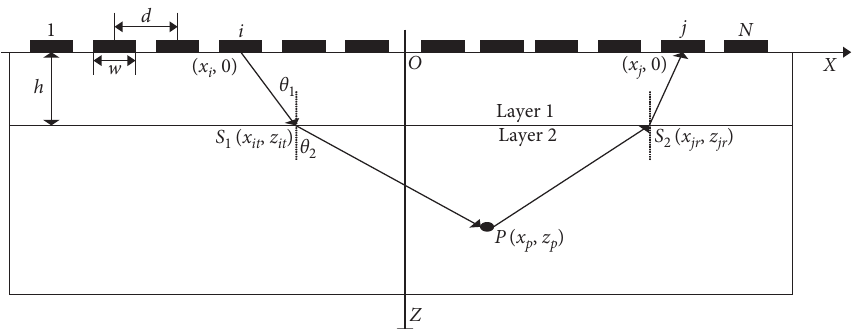
Figure 2: The principle of traditional multilayer structure